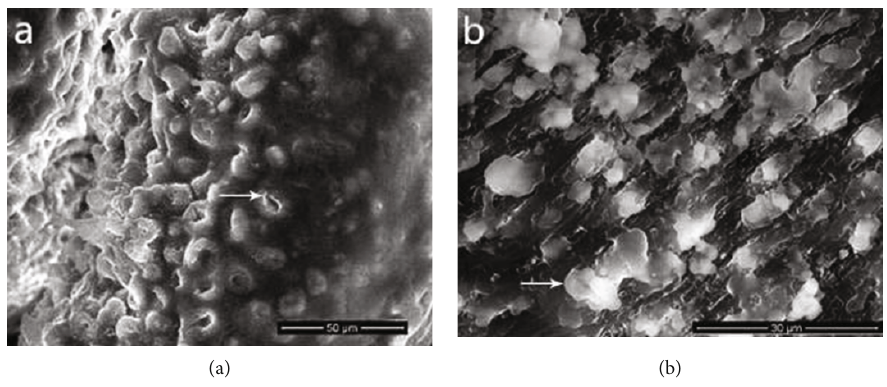
Figure 8: E ff ect of traditional treatment by PZQ